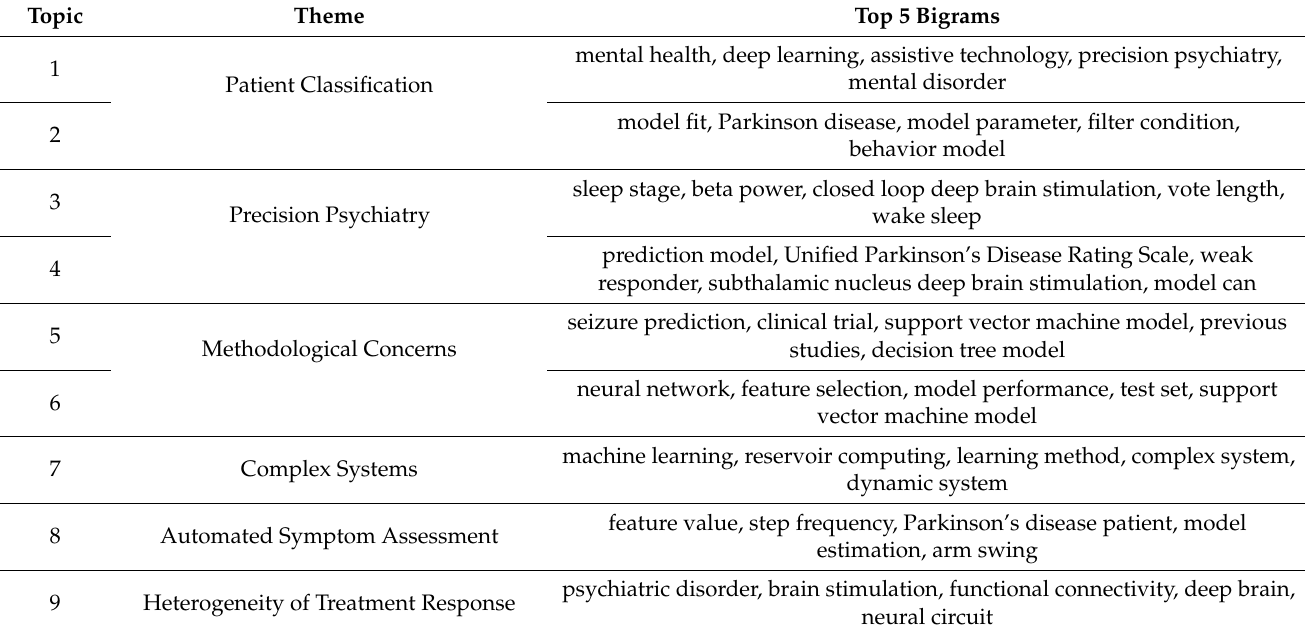
Table 2. Themes and Top Five Topic